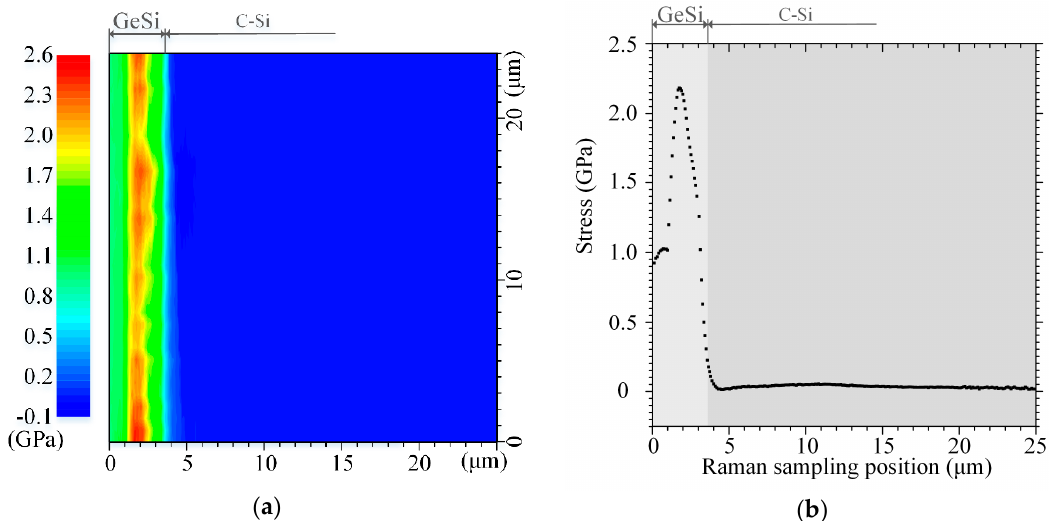
Figure 10. ( a ) Distribution image of residual stress on sample cross-section, ( b ) mean residual stress along the depth